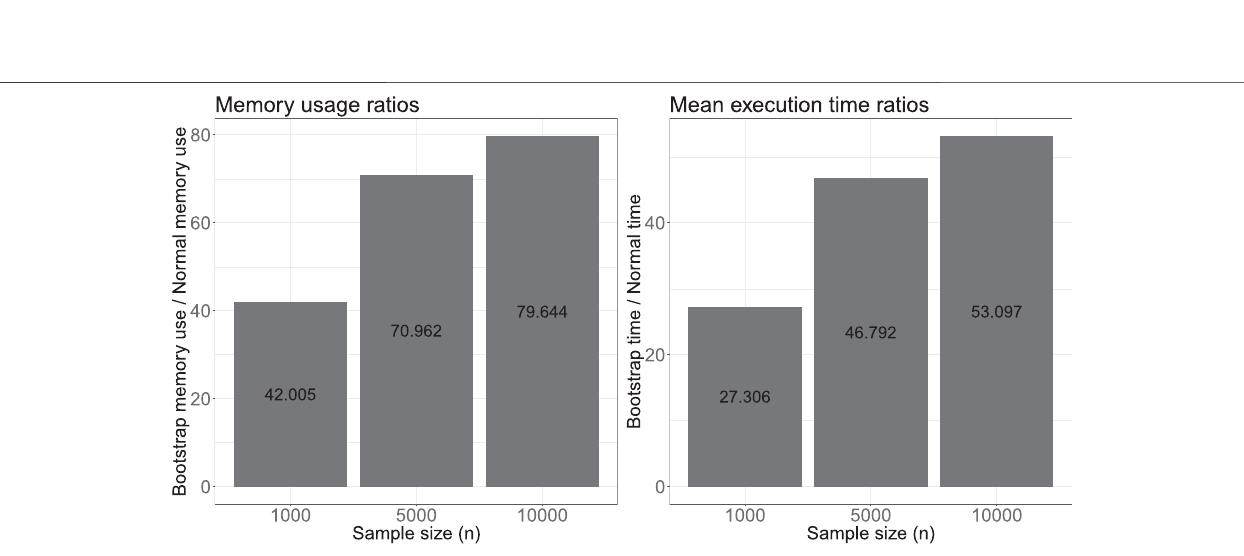
FIGURE 6 | Computational benchmark metric ratios of con fi dence interval estimation using the naïve bootstrap over the asymptotic normality approach.